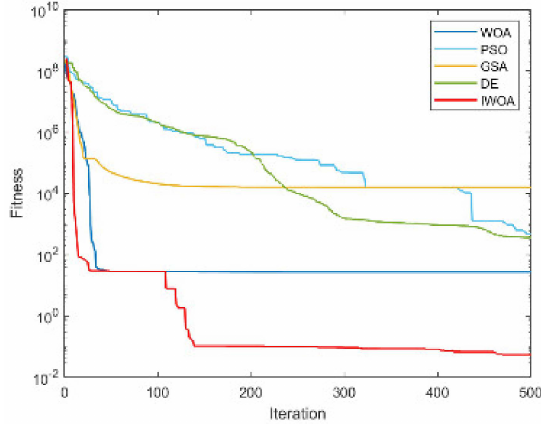
Figure A3. The convergence curve for solving F3.